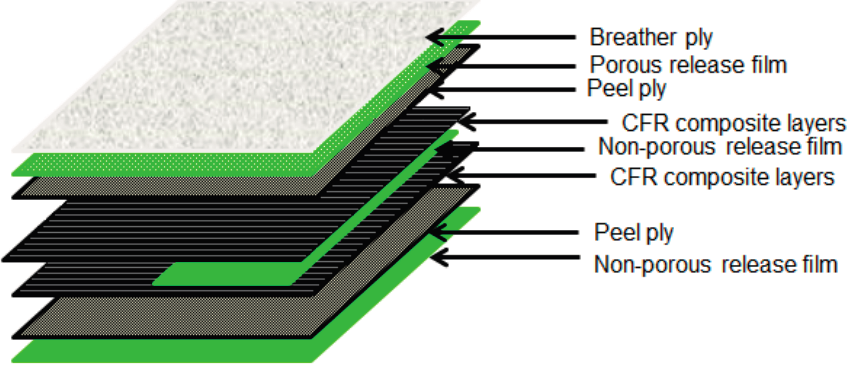
Figure 3. The order of materials used in the hand-layup technique for the fabrication of unidirectional CFRP composite laminates.